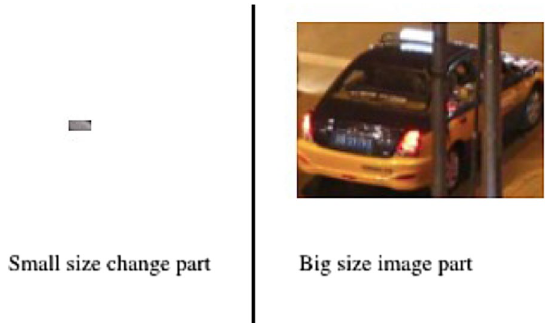
Fig. 3 Example of small changes that can be ignored compared to change sent to the